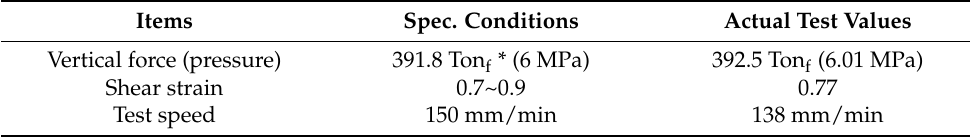
Table 1. Shear modulus test conditions.